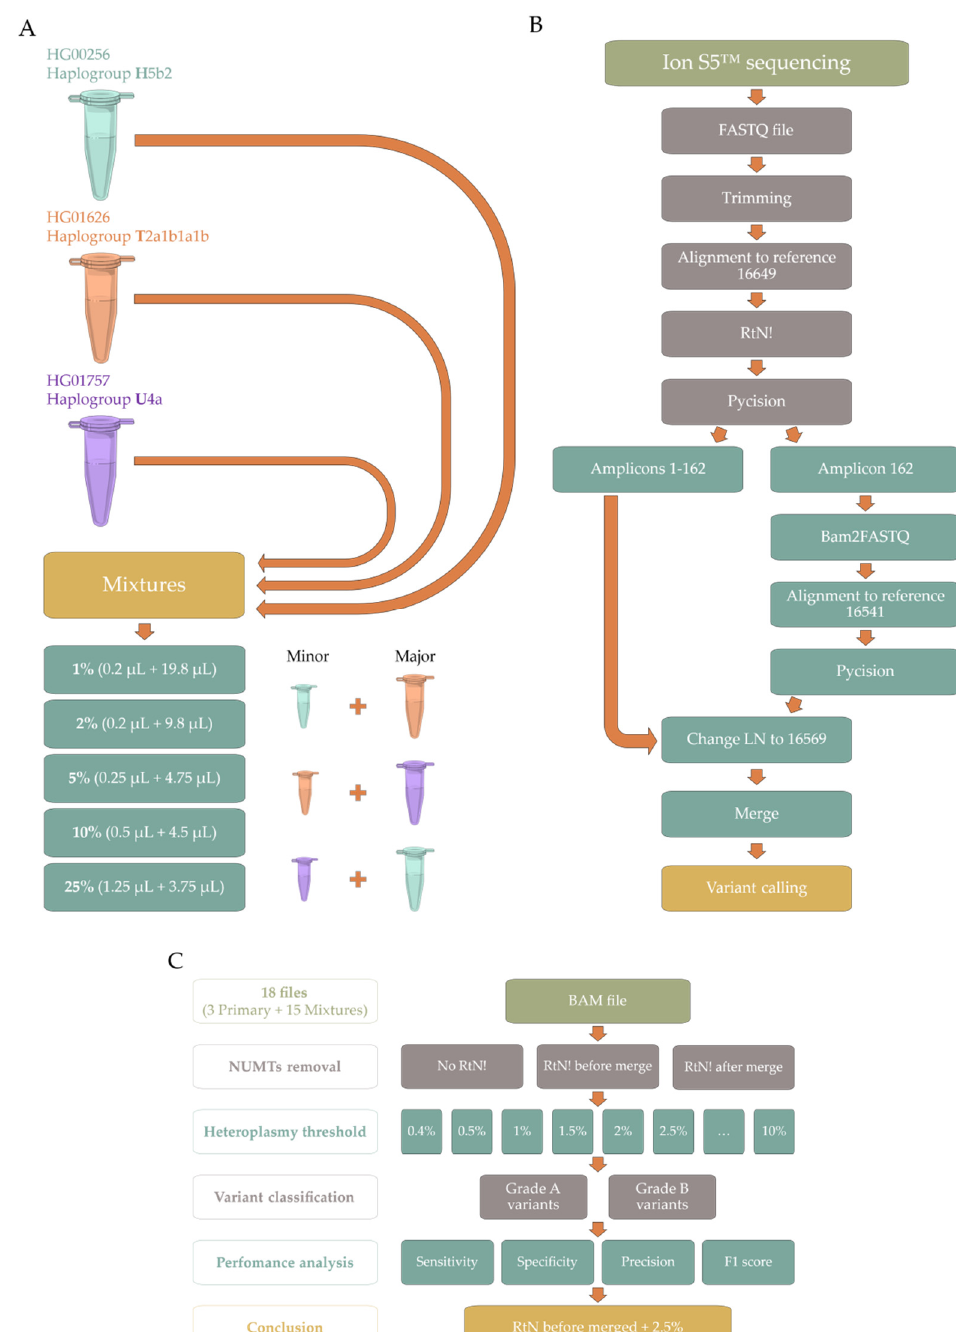
Figure 1. Schematic representation of our workflow. ( A ) Wet lab approach to performing the 15 mixtures from the Coriell Institute for Medical Research’s samples, which have been analyzed within the 1000 Genomes Project—templates from Servier Medical Art (CC BY 3.0) were adapted, and are freely available at https://smart.servier.com (accessed on 1 November 2021); ( B ) Visual representation of the PrecisionCallerPipeline (PCP); ( C ) Visual representation of the optimization approach to NUMT removal and heteroplasmy threshold. Abbreviations: NUMTs—nuclear insertions of mitochondrial DNA.